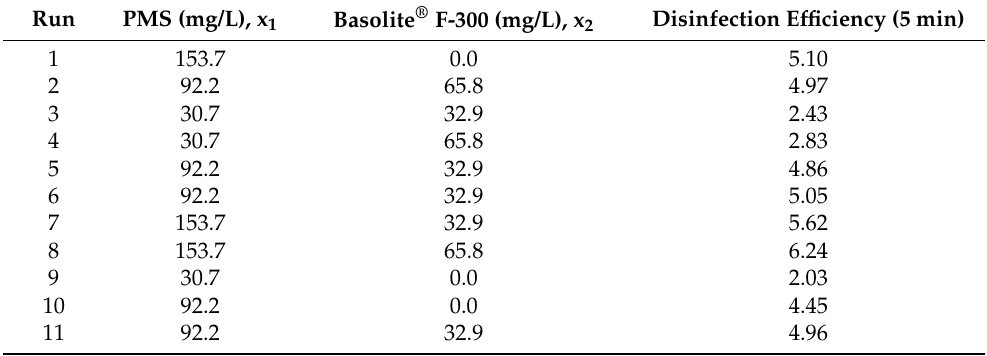
Table 2. Experimental Central Composite Experimental Design matrix and responses in actual factors. Data represent the mean values for triplicate samples with a standard deviation below